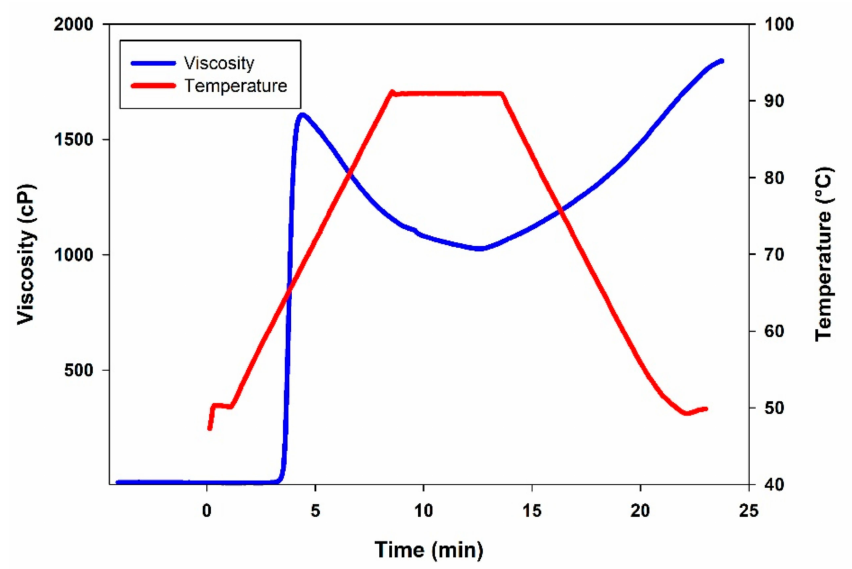
Figure 3. Rapid viscoanalysis (RVA) pasting curve of Ceiba aesculifolia subsp. parvifolia tuber starch.